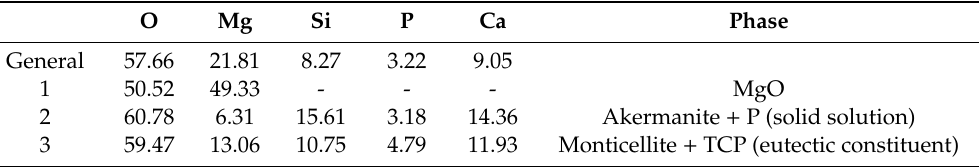
Table 5. EDS analysis (atom %) for directionally solidified rods at 300 mm / h.